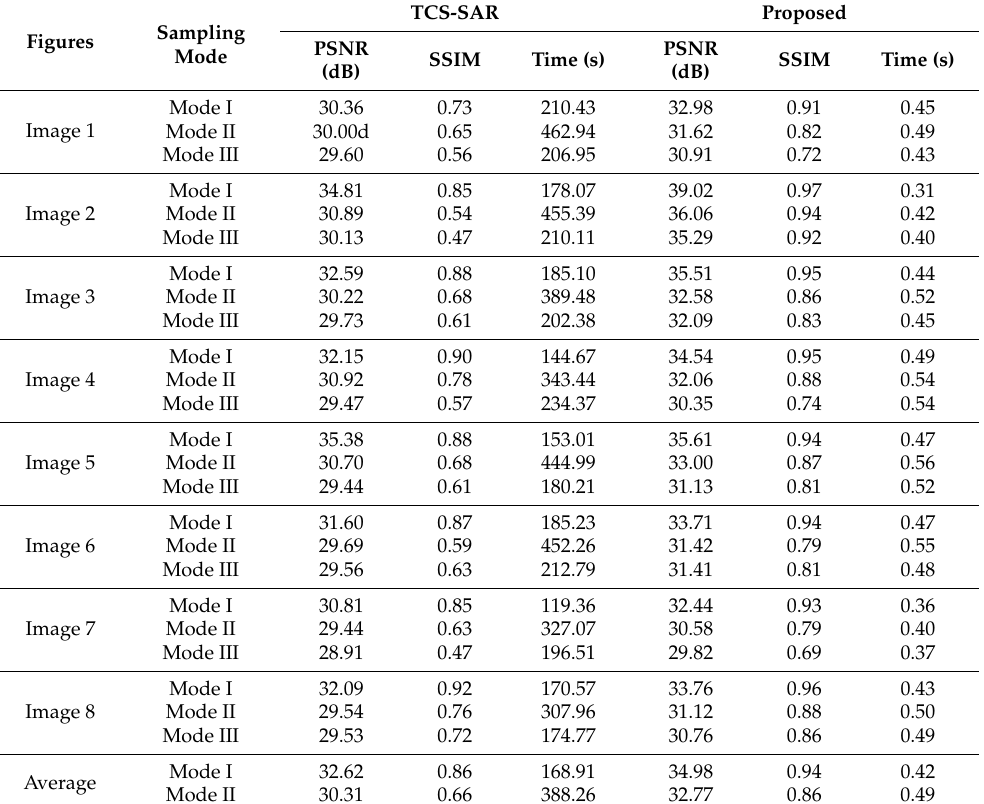
Table 4. Quality metrics for reconstructed images.